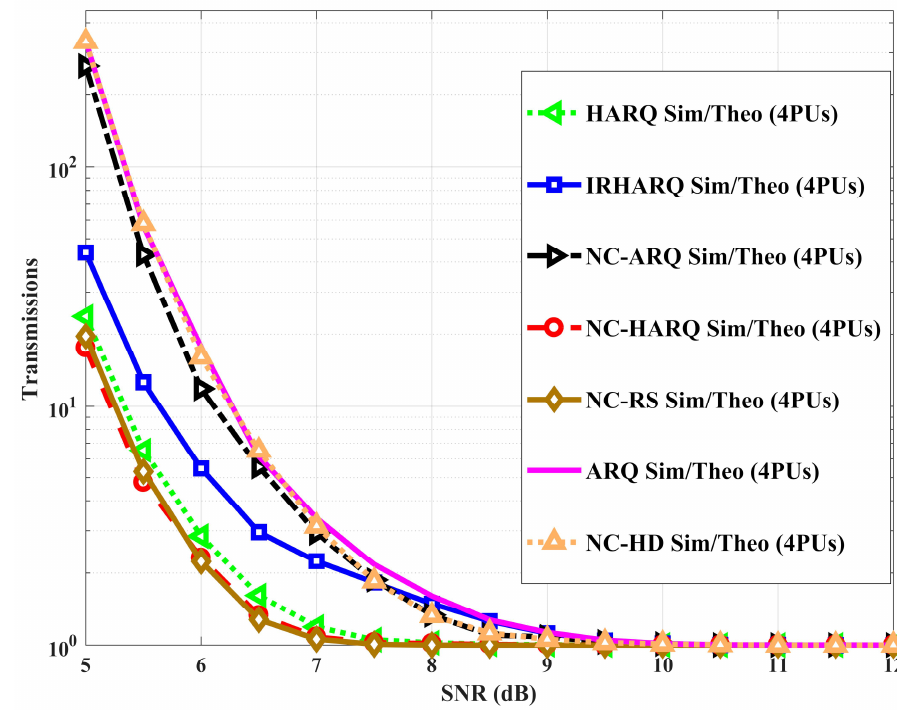
Figure 2. Broadcasting throughput comparison.